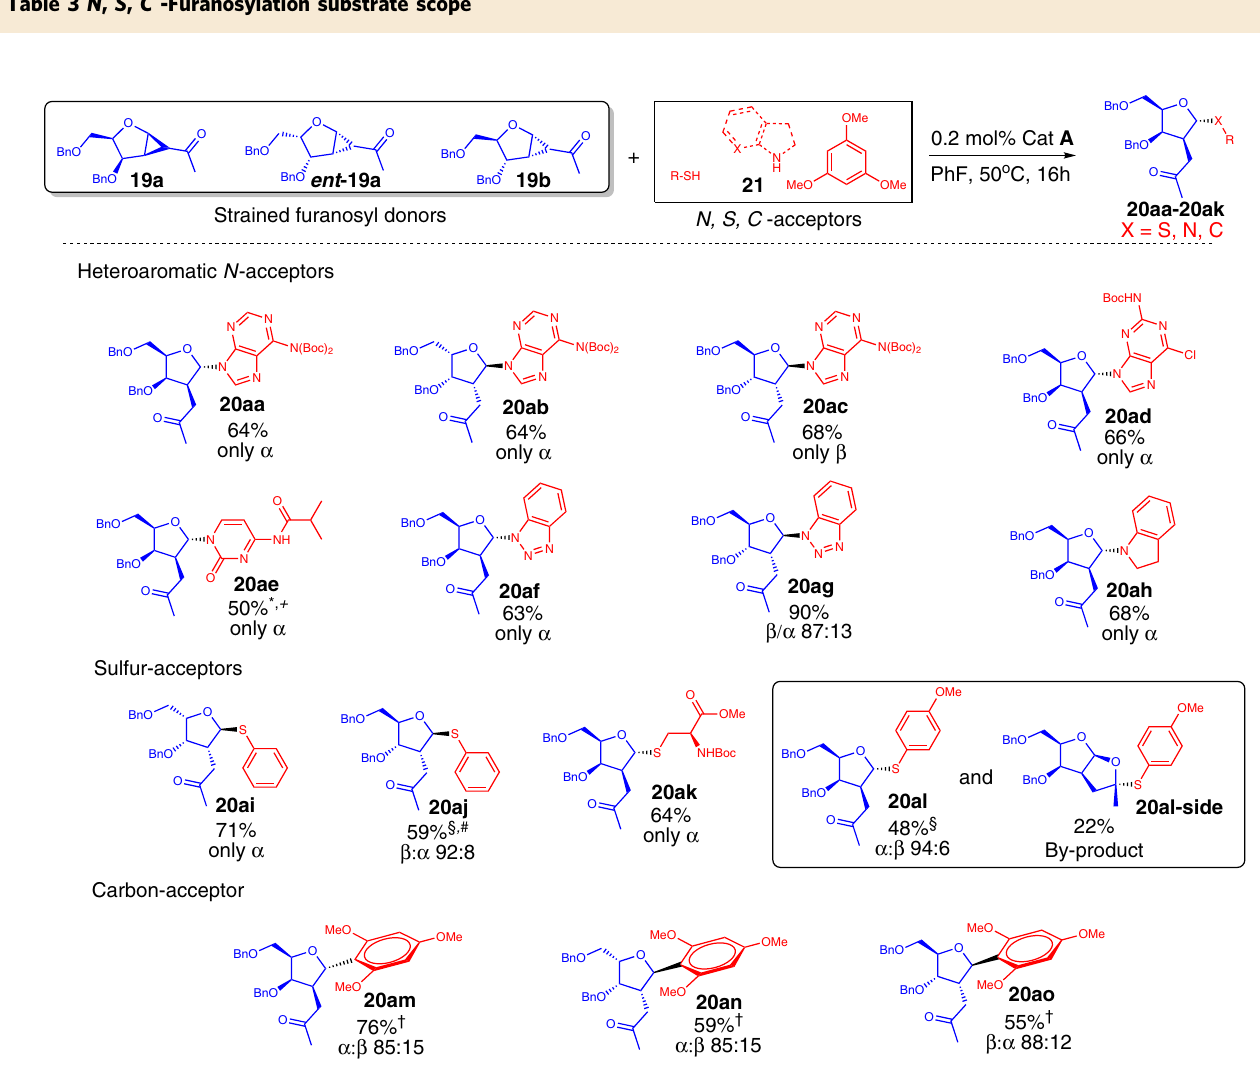
Table 3 N , S , C -Furanosylation substrate